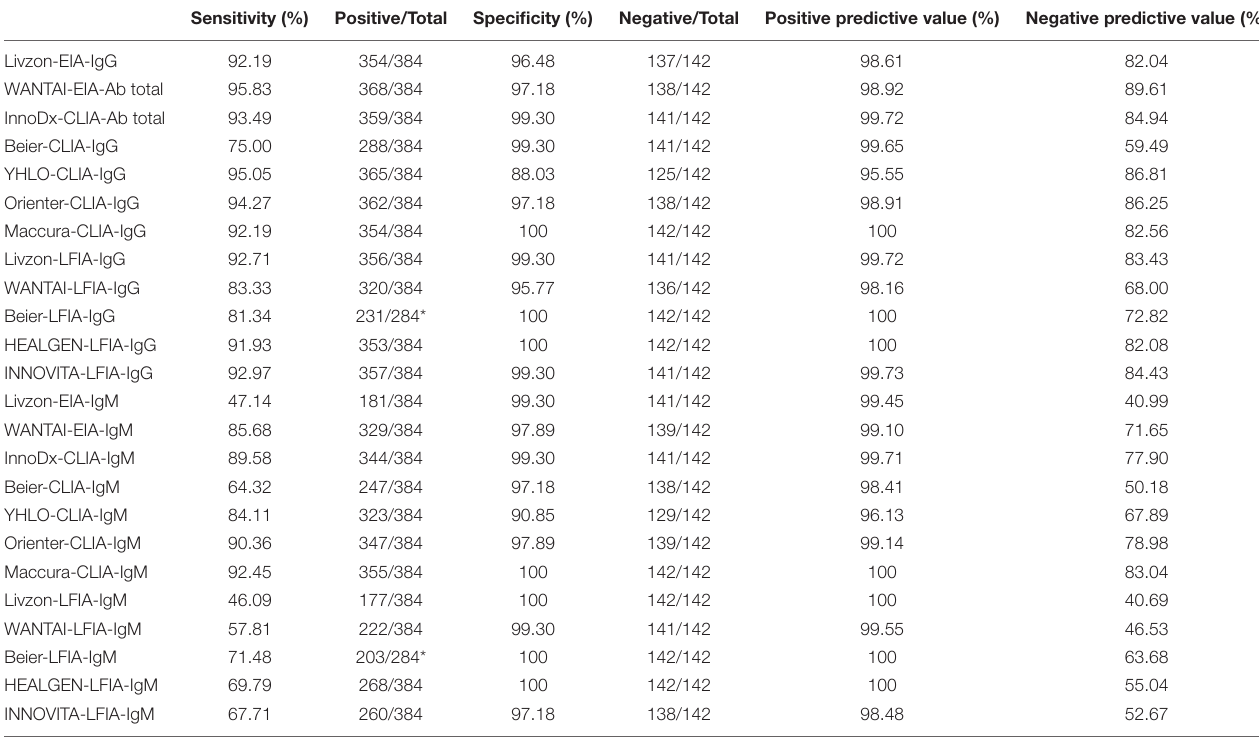
TABLE 1 | The sensitivity and specificity of 24 SARS-CoV-2 antibody assays. Sensitivity (%) Positive/Total Specificity (%) Negative/Total Positive predictive value (%) Negative predictive value